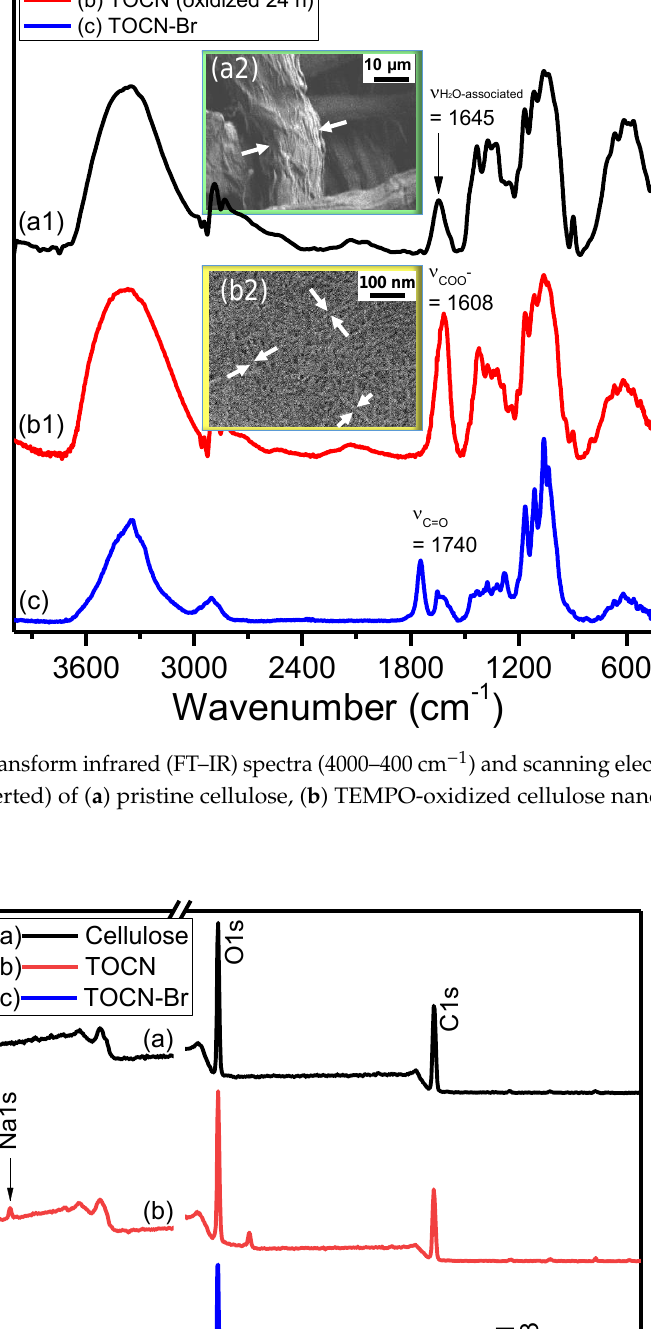
Figure 1. Fourier transform infrared (FT – IR) spectra (4000 – 400 cm − 1 ) and scanning electron microscopy (SEM) images (inserted) of ( a ) pristine cellulose, ( b ) TEMPO-oxidized cellulose nanofibers (TOCN), and ( c ) TOCN – Br.